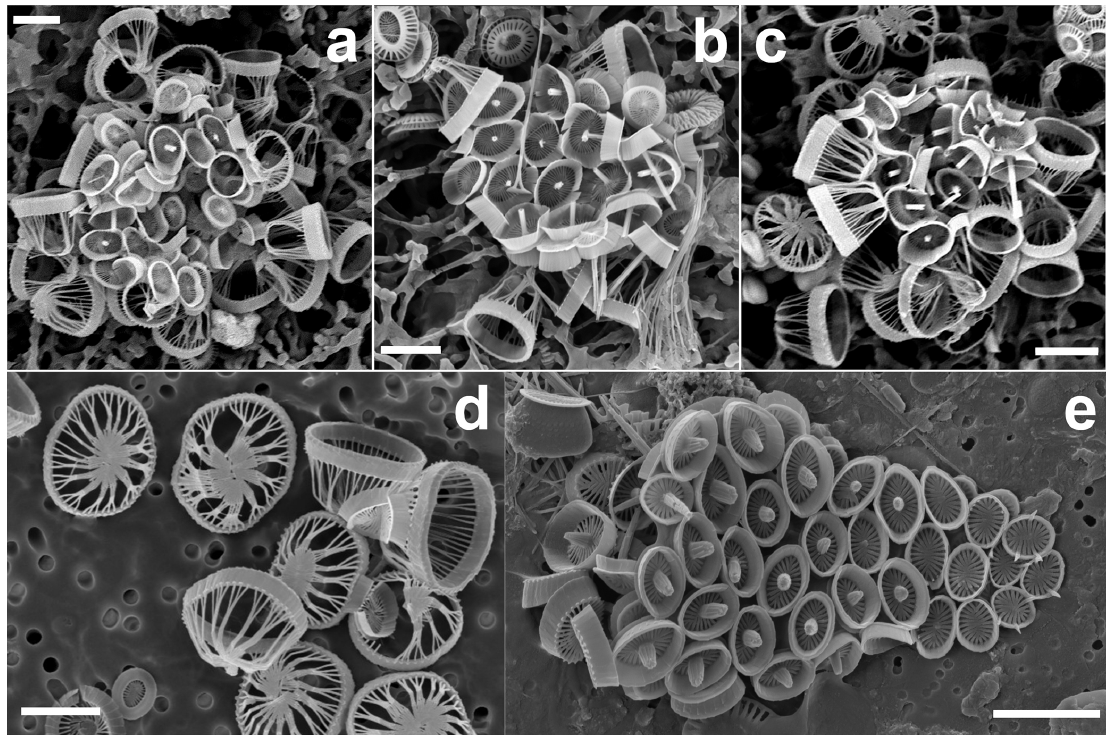
Figure 1. (a–c) Complete coccospheres of Syracosphaera winteri sp.nov., displaying endothecal coccoliths and basket-like exothecal coc- coliths. The endothecal coccoliths are muroliths, which appear with or without central processes perpendicular to the coccolith plane ( a : GoA, 13 September 2017, 80m; b and c : GoA, 17 August 2017, 80m). (d) Series of free basket-like-shaped exothecal coccoliths of S. win- teri (Tsagaraki, NE Atlantic, 50m); (e) for comparative purposes, coccosphere of Syracosphaera noroitica displaying endothecal coccoliths similar to those of S. winteri (Mater II Stn 69/11, October 1999, 50m). Scale bars: 3µm. Panel (d) is courtesy of Tatiana Tsagaraki, Bergen